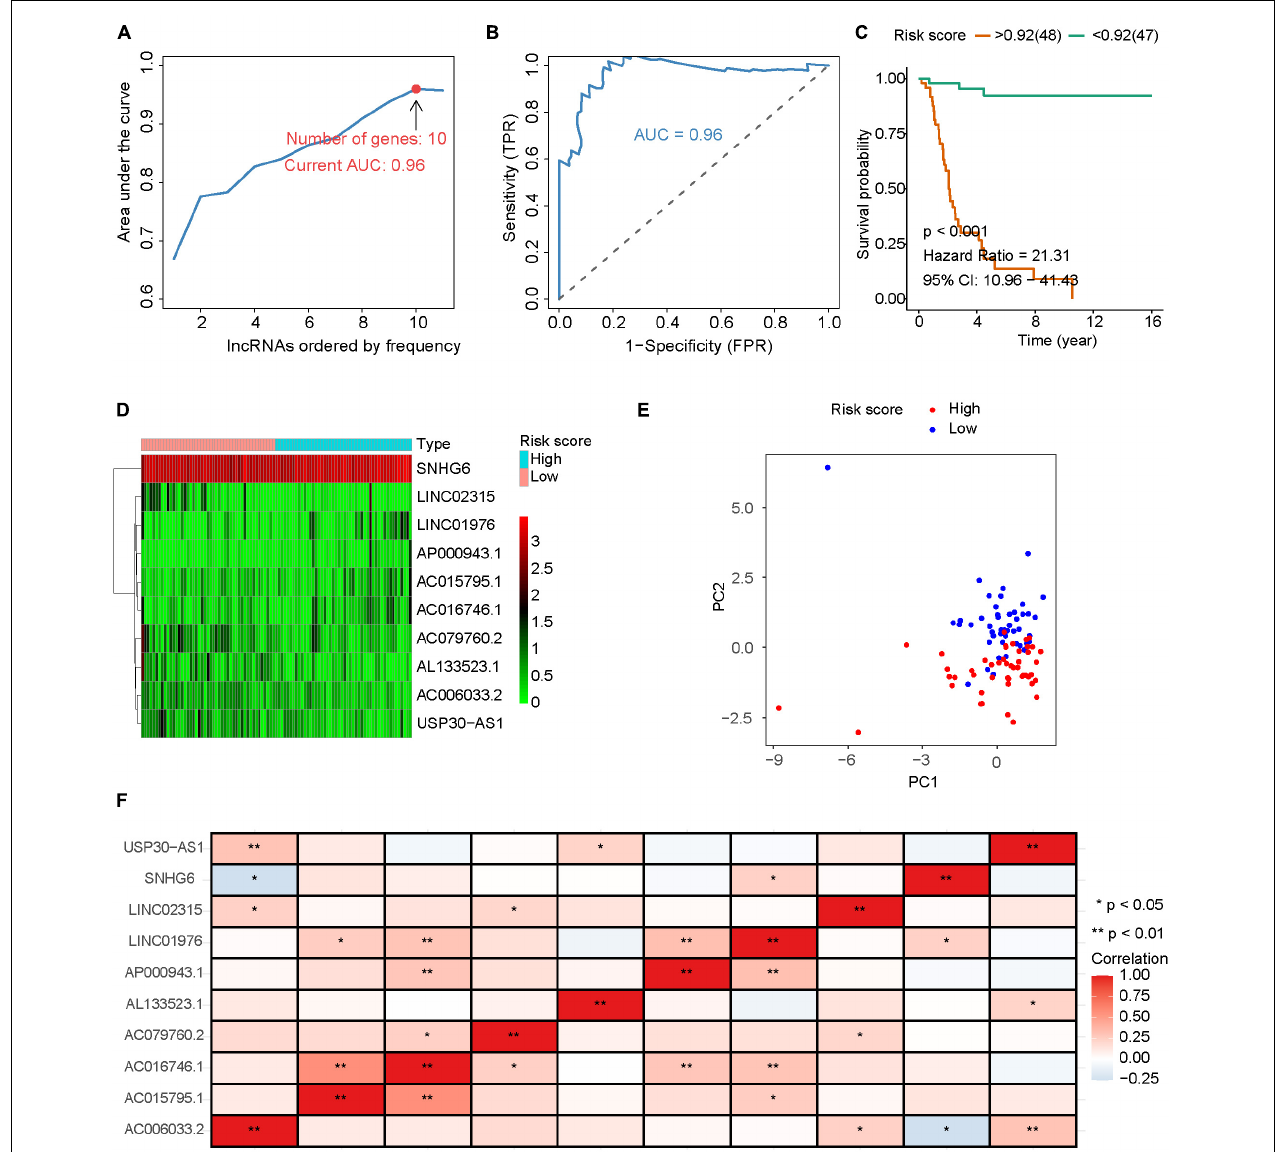
FIGURE 1 | Construction of IRLs prognostic signature. (A) Iterative LASSO and Cox regression analysis are used to screen IRLs signature with the best AUC. (B) The ROC curve with the best AUC. (C) Osteosarcomas were grouped according to the optimal cut-off value of risk score, and survival analysis was performed. (D) Expression levels of 10 lncRNA in IRLs signature. (E) PCA analysis was performed with IRLs signature. (F) Correlation analysis among 10 IRLs in IRLs